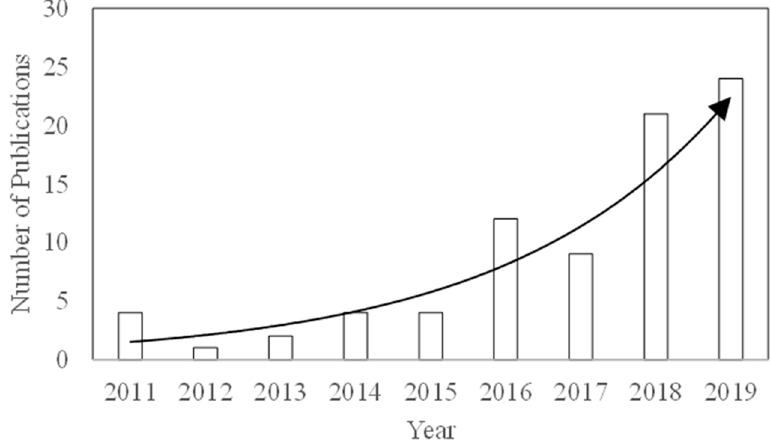
Figure 1. Number of publications related to evapotranspiration estimation using artificial intelligence from 2011 to 2019.